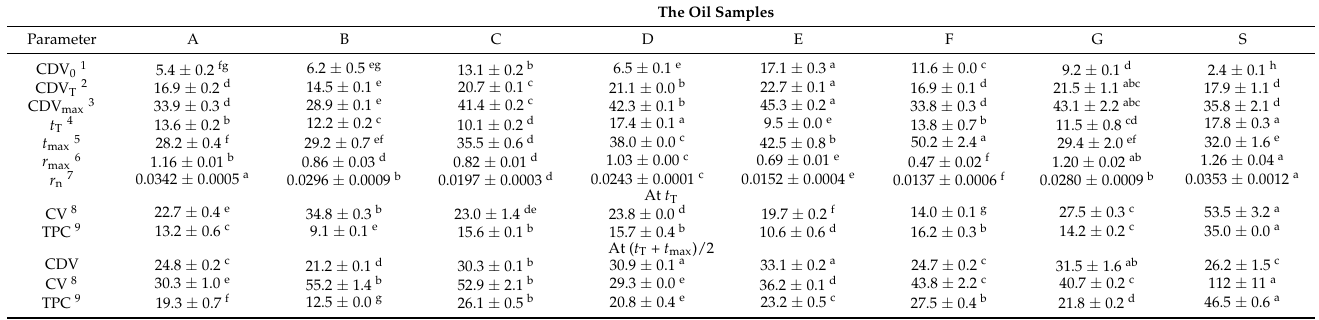
Means ± SD (standard deviation) within a row with the same lowercase letters are not significantly different at p < 0.05. 1 Conjugated diene value (mmol/L) at t = 0, representing the initial quality of the oils; 2 Conjugated diene value (mmol/L) at the turning point of the sigmoidal equation; 3 The maximum CDV (mmol/L) attained during the frying process; 4 The time (h) required to reach CDV T ; 5 The time (h) at which conjugated dienes practically approach CDV max ; 6 Maximum rate of the accumulation of conjugated dienes (mmol/L h); 7 Normalized r max (/h); 8 Carbonyl value ( µ mol/g); 9 The total content of polar compounds (%). Distinct from the plateau-reaching pattern of the CDV during frying [14], total